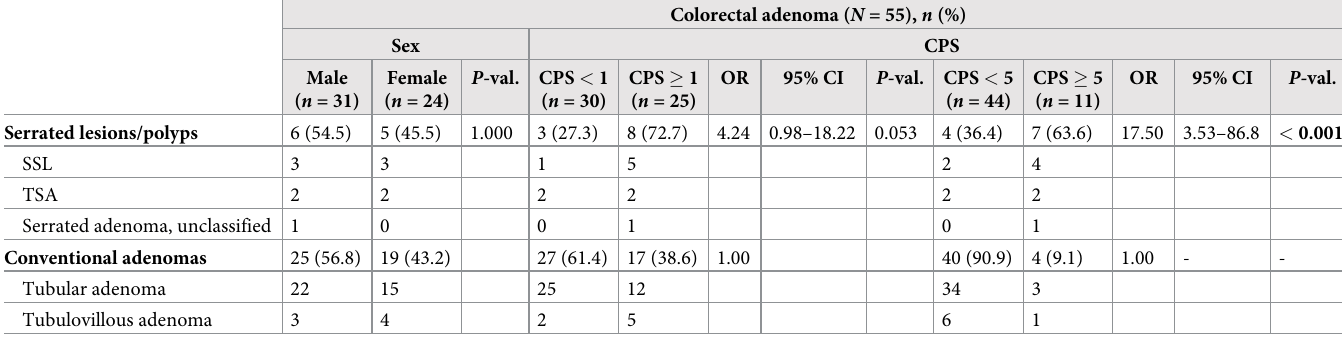
Table 2. Association of sex or PD-L1 CPS with colorectal adenoma classification.